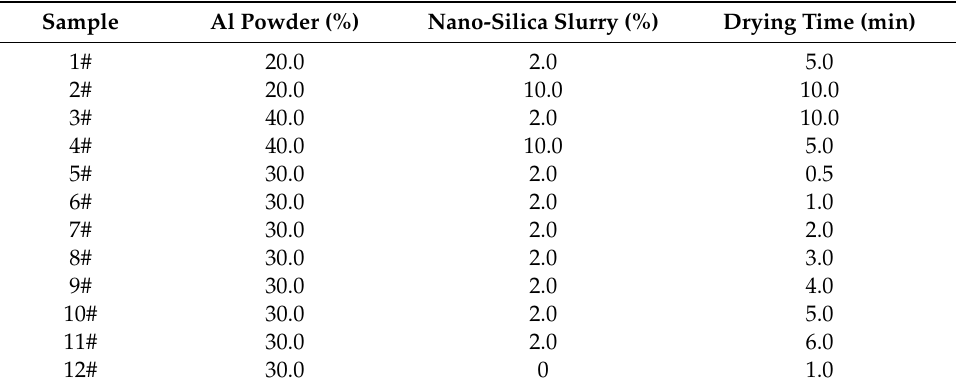
Table 1. Experiment arrangement and